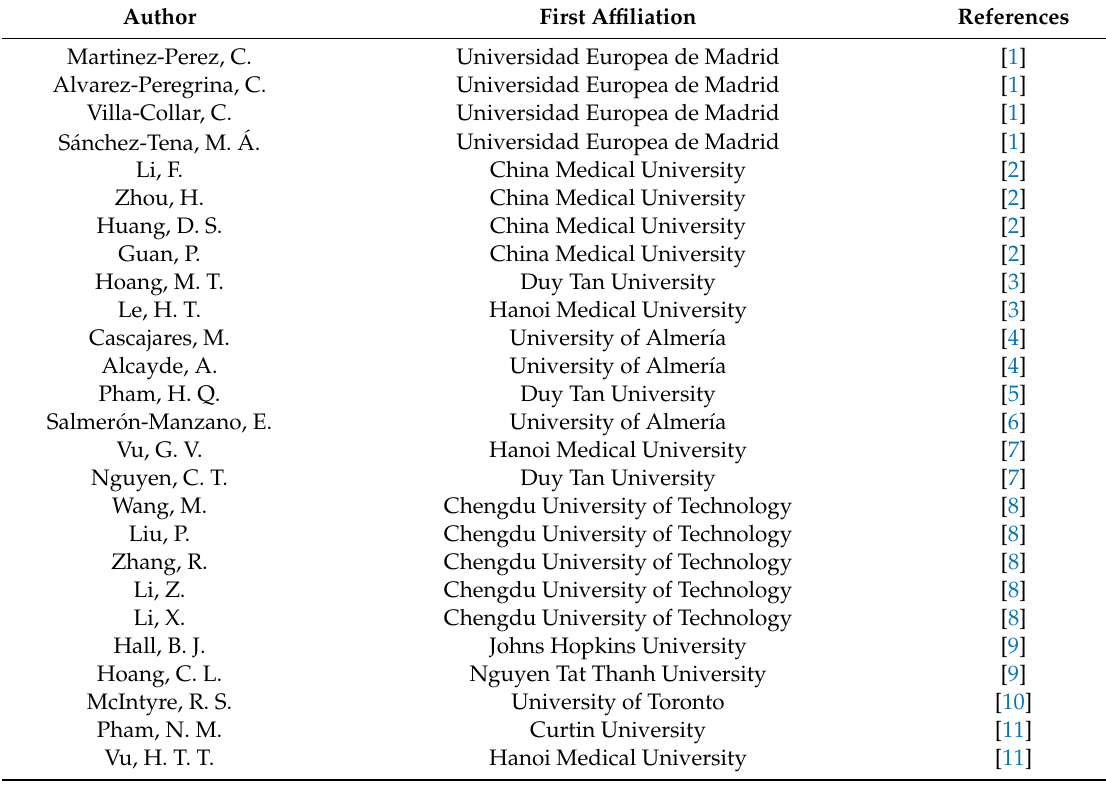
Table 2. Authors and a ffi